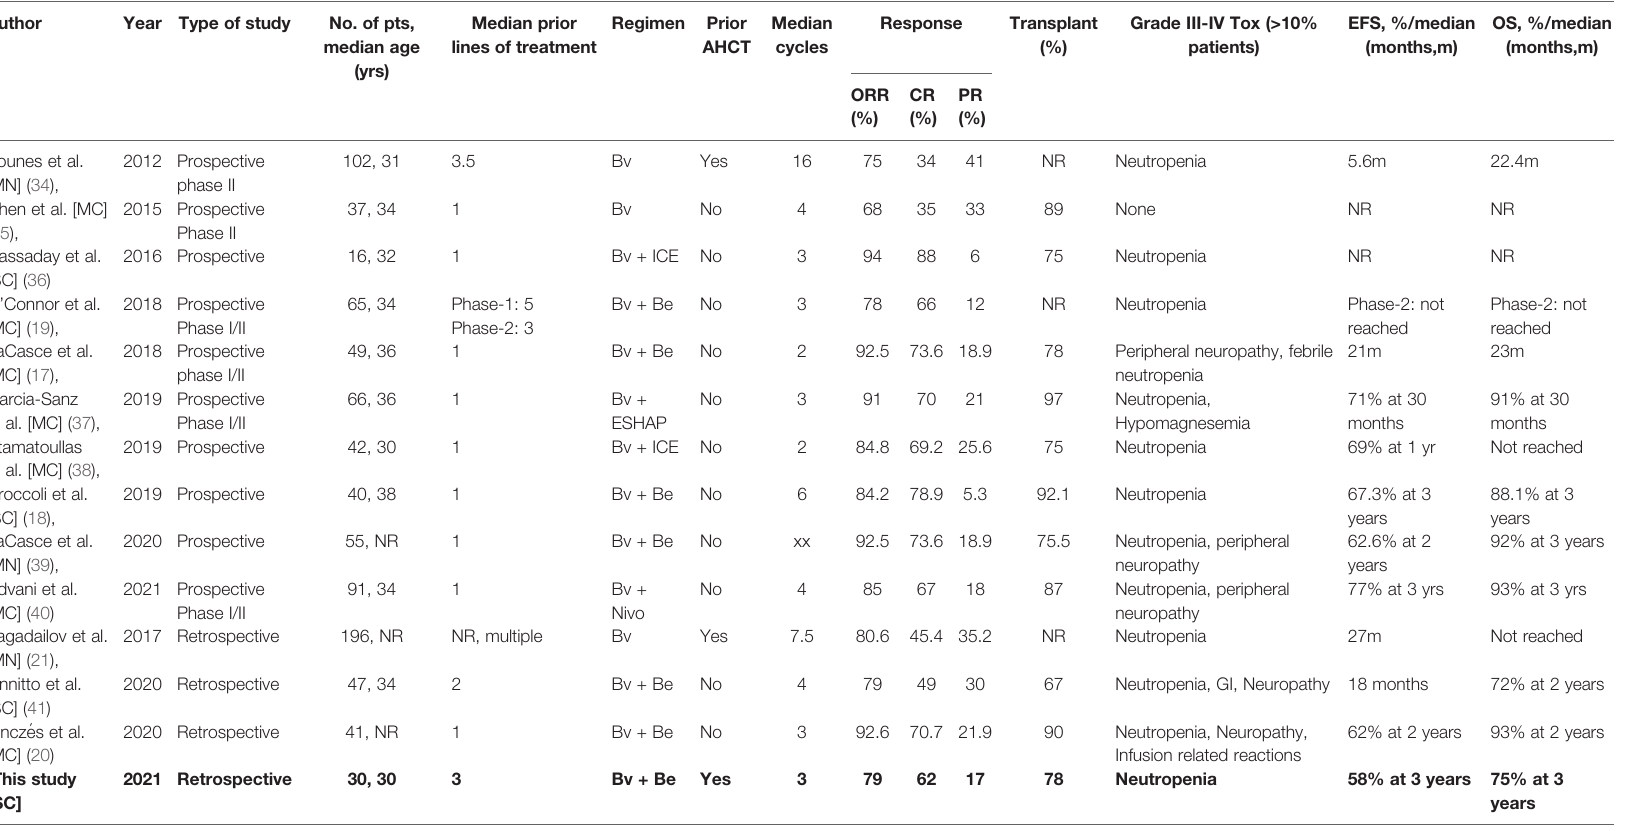
TABLE 5 | Selected studies with Brentuximab based treatment in R/R